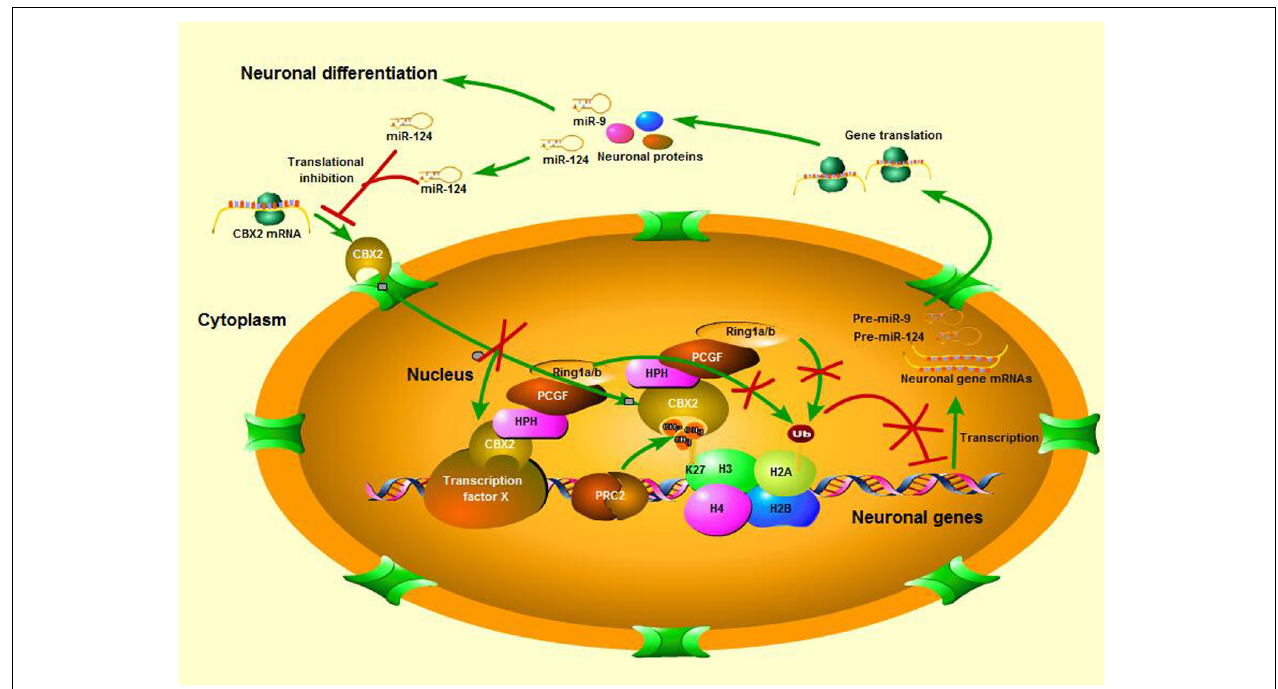
FIGURE 7 | A schematic is shown of neuronal differentiation mediated by the miR-124 regulated CBX2